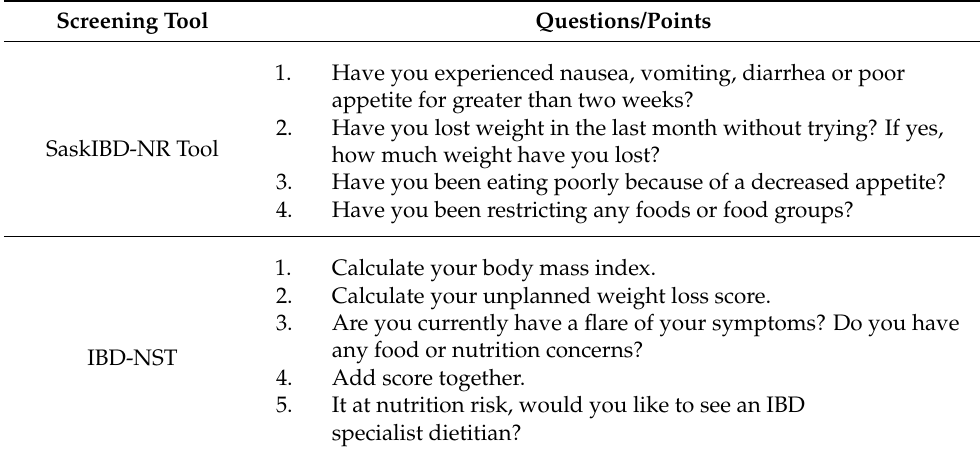
Table 2. Screening nutritional tools specific for IBDs [73,74]. Screening